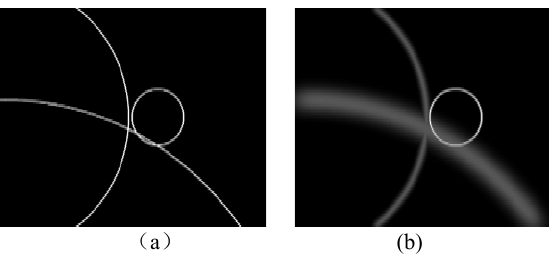
Figure 6 . (a) Signal space score map generated by setting parameters such as beacon distance. (b) The results of correcting the circles plotted for each base station using the confidence parameter.